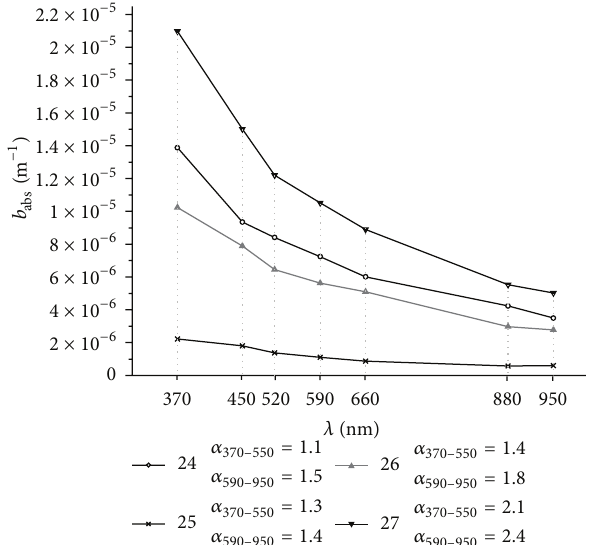
Figure 6: The light Angstr¨om exponent of the absorption coeffi- and 𝛼 nm during May 24–27, 2011. cients 𝛼 370–520 590–950